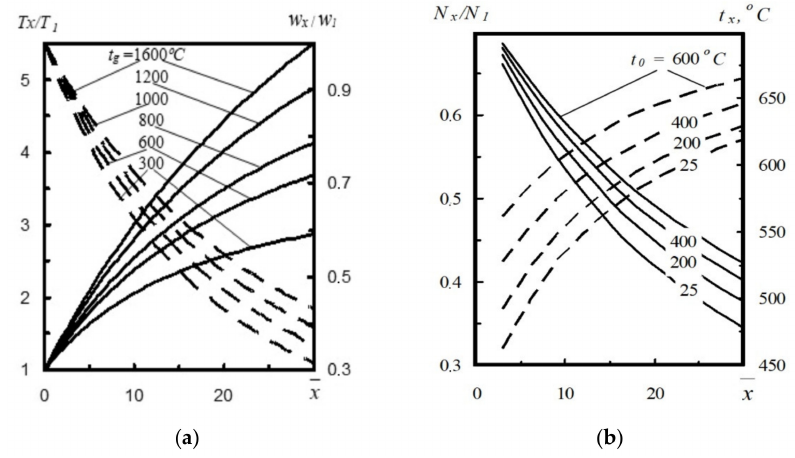
Figure 4. ( a ) Change of T x / T 1 (—-) and rate w x / w 1 (- ), depending on the change of temperature in the converter body t g at a different distance x from the nozzle [2] and ( b ) influence of nitrogen temperature t 0 on temperature t x (—-) and ratio N x / N 1 (- ) at a different distance x from the nozzle [17].